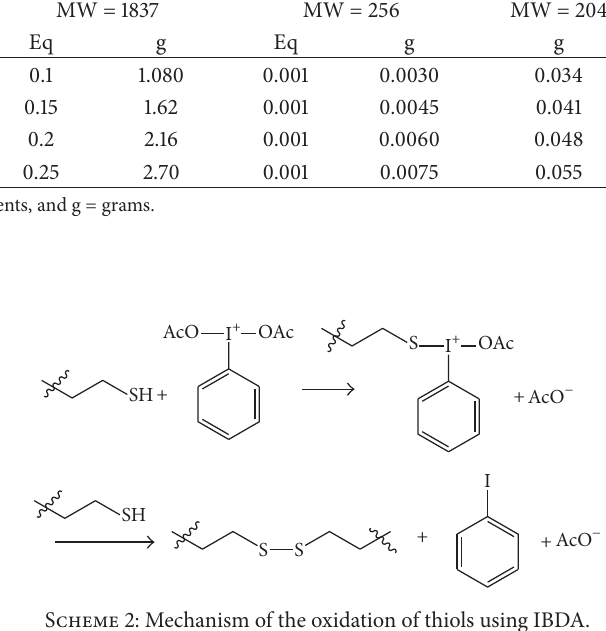
Table 1: Composition of the photocurable epoxy/thiol-ene formulations in equivalents and grams. DGEBA Formulation